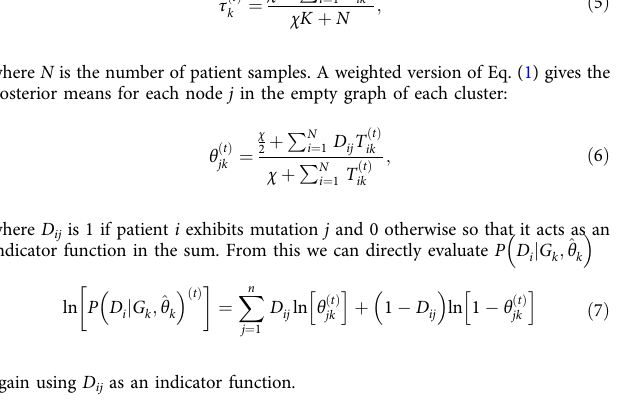
EM MAP algorithm . To fi nd the MAP estimates for the mixture model we repeat the following steps: (1) given the membership probabilities, update the posterior